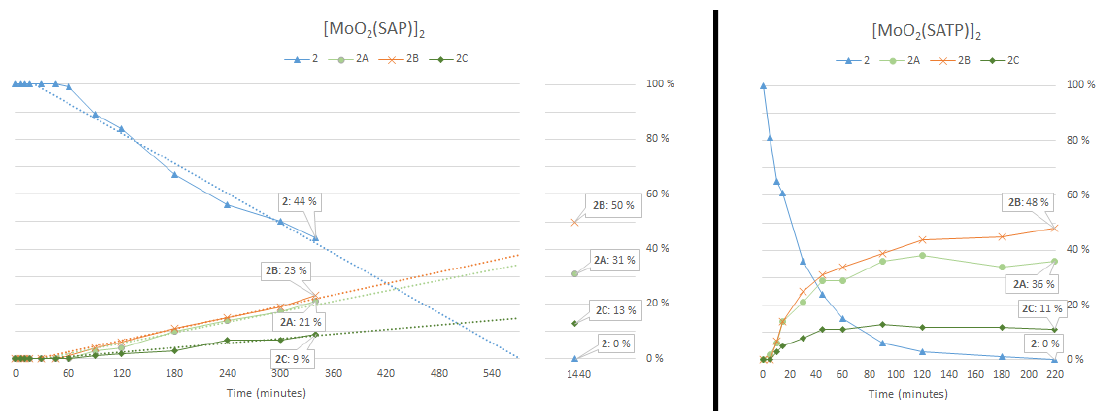
Figure 4. Dimethyl-dihydroimperanene, used as internal standard in the kinetic studies.